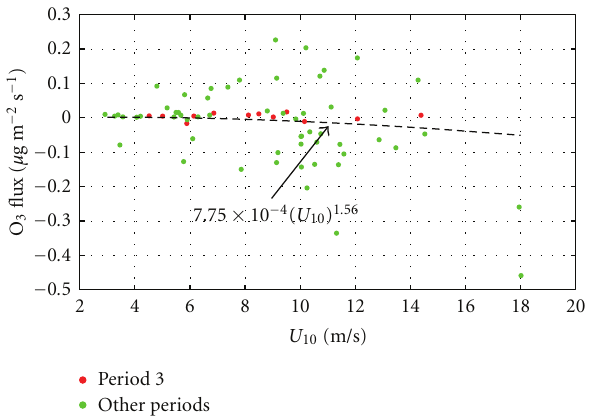
Figure 6: Relationship between 10m wind speed and O 3 fluxes measured at 22 m. The black line represents the power-law relation between the 10m wind speed and O 3 fluxes which was calculated 1 . 56 ( r 2 = 0 . 344). The red data points = 7 . 75 × 10 − 4 ( U as F O 10 ) 3 represent data from period (3) in Figure